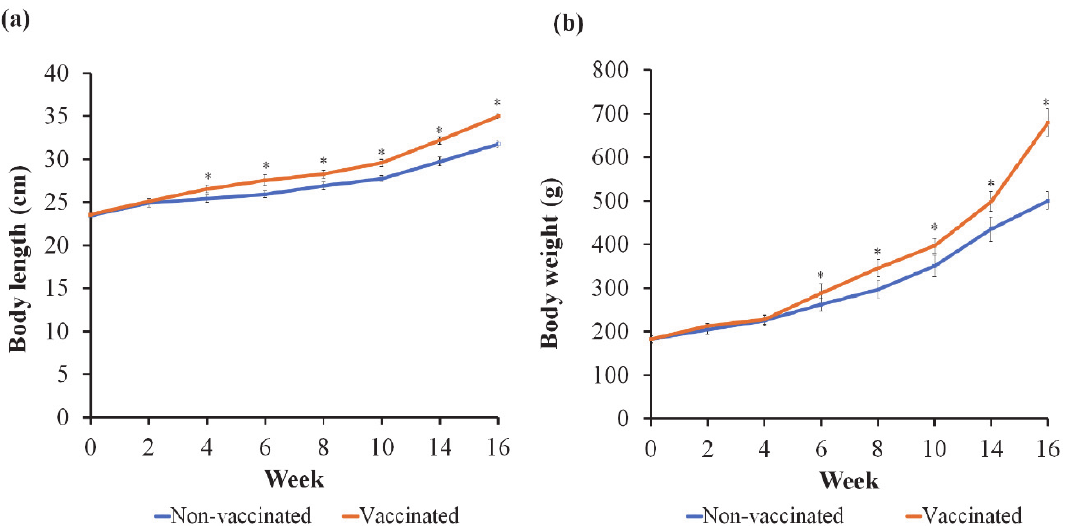
Figure 2. The body length ( a ) and body weight ( b ) of Asian seabass throughout the 16-week vac- cine trial. Asterisks (*) indicate significant ( p < 0.05) differences between the vaccinated and non- vaccinated groups. Table 1. Growth performance parameters and survival rate of Asian seabass fed with vaccinated feed for 16 weeks. Asterisks (*) indicate a significant difference ( p < 0.05) from the non-vaccinated. Treatment Group Parameters Non-Vaccinated Vaccinated